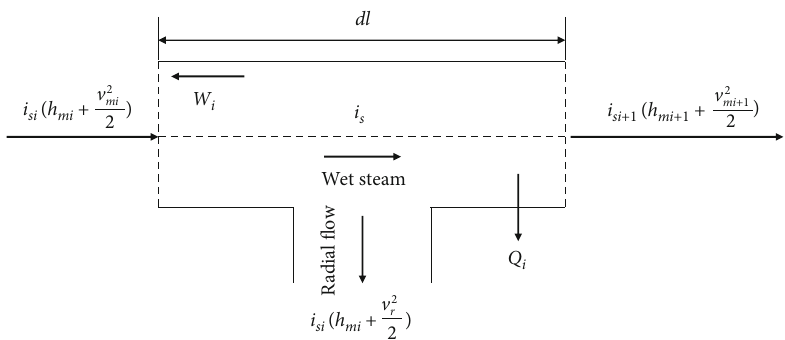
Figure 2: Schematic fi gure of energy conservation in an in fi nitesimal section.